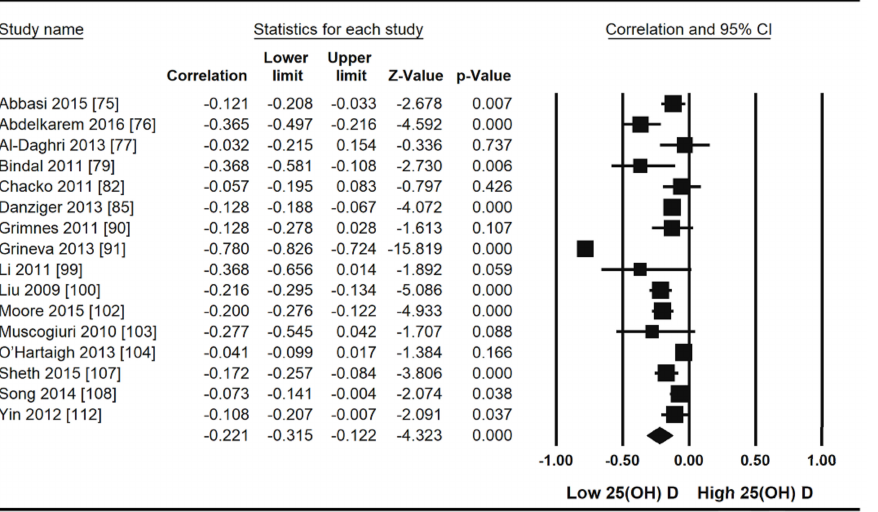
Figure 6. Non-diabetic subject studies for the medium BMI quartile (25–30): Forest plot showing the relationship of vitamin D status and HOMAIR [75–77,79,82,85,90,91,99,100,102–104,107,108,112].